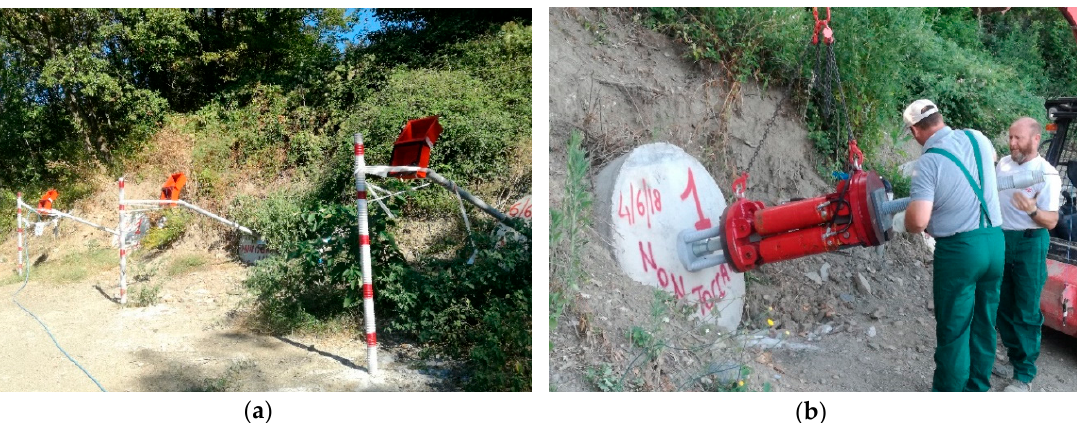
Figure 13. In-situ installation of the composite bars equipped with optical cables: ( a ) view of the external portion of bars with metallic boxes for hosting cables; ( b ) set up of the oleo-dynamic piston for the application of pre-tension to the bars.